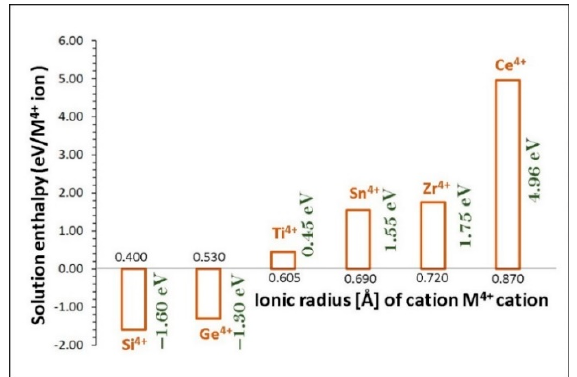
Figure 7. Enthalpy of solution of RO 2 (R = Si, Ge, Ti, Sn, Zr and Ce) with respect to the R 4+ ionic radius in Li 2 MnO 3 .